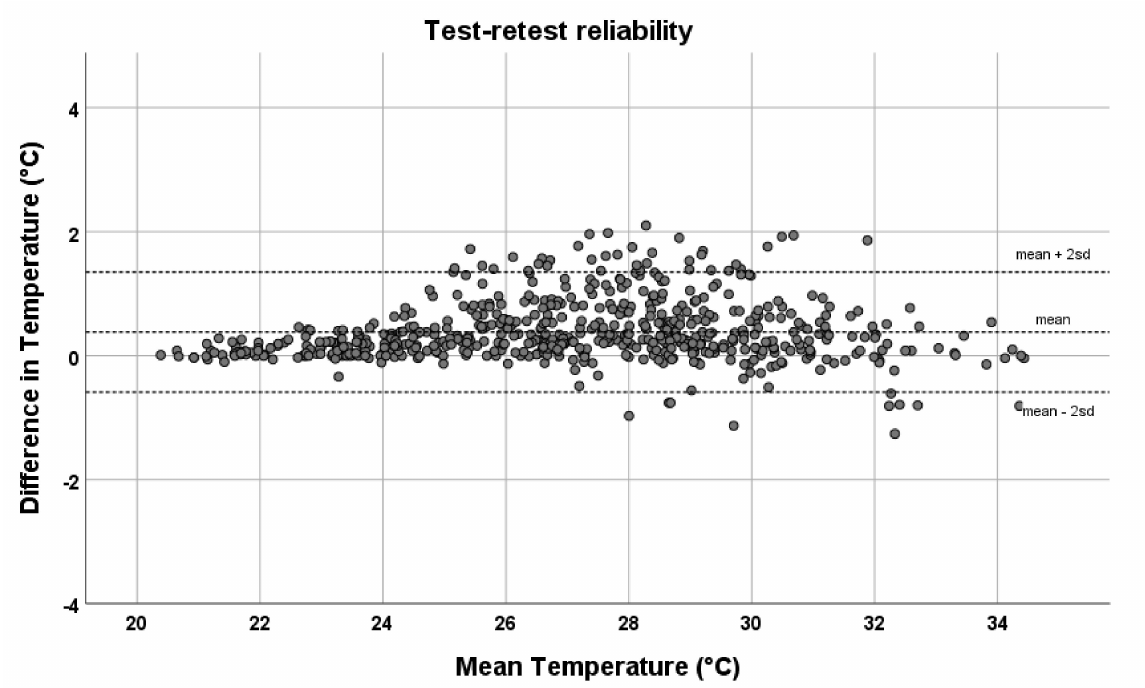
Figure 4. Bland–Altman plots with limits of agreement (i.e., mean ± 2sd) between repeated temperature assessments using the platform system for all 28 foot regions for both feet. In these plots, the temperature difference between repeated assessments (assessment 1–assessment 2) is shown against the average of repeated assessments.